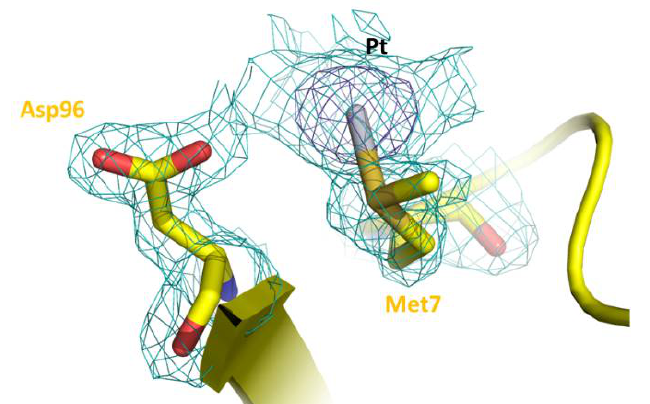
Figure 2. Pt-containing fragment binding site in the structure of the OXA/β-lactoglobulin adduct. Pt binds the side chain of Met7. 2Fo-Fc electron density map is contoured at 1.0 σ (cyan) and 5.0 σ (blue) level.